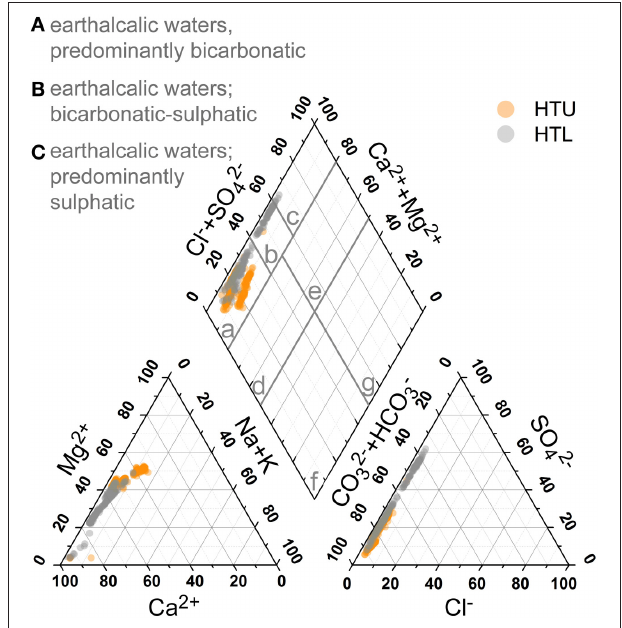
FIGURE 8 | Piper diagram of groundwater samples recorded for more than 4 years and all five well locations. Classification after Furtak and Langguth (1967)